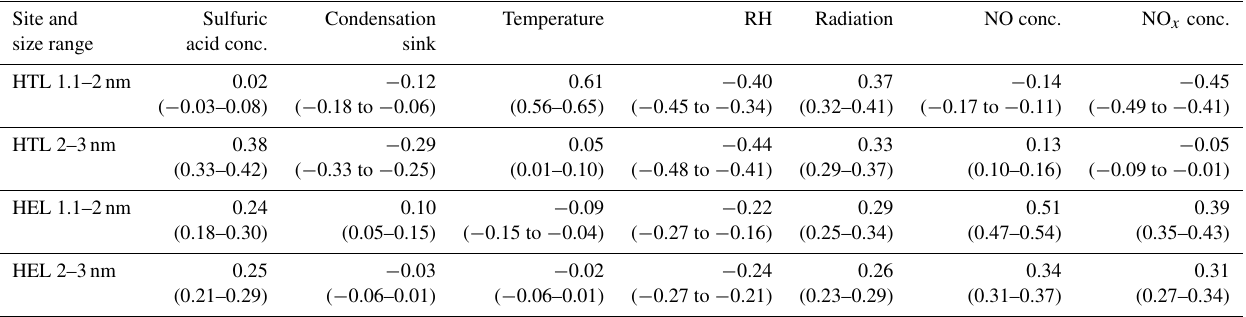
Table 6. Pearson’s correlation coefficients between particle concentration in the size ranges of 1.1–2 and of 2–3nm and other variables in Hyytiälä (HTL) and Helsinki (HEL) in 2015–2016. The confidence intervals for the coefficients (the 95% confidence level) are shown in